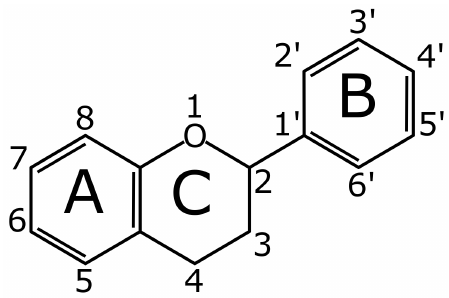
Figure 1. Basic flavonoid